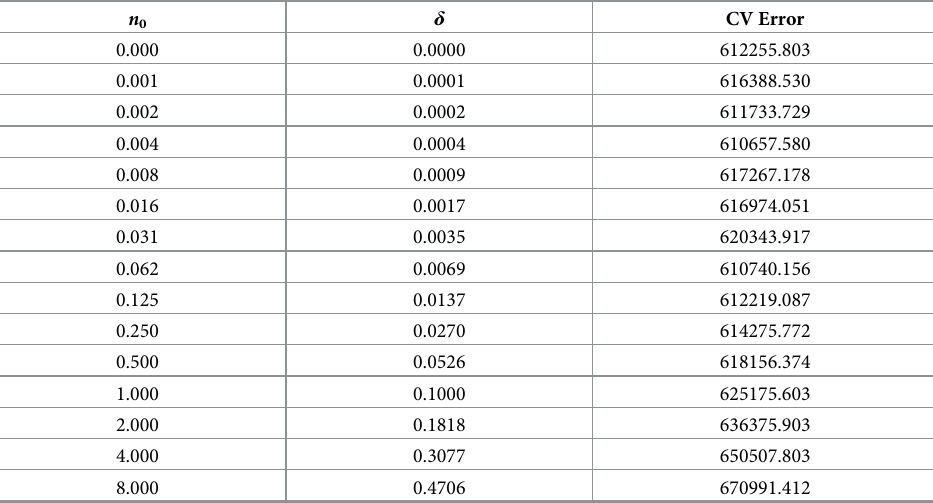
as a function of n 0 2